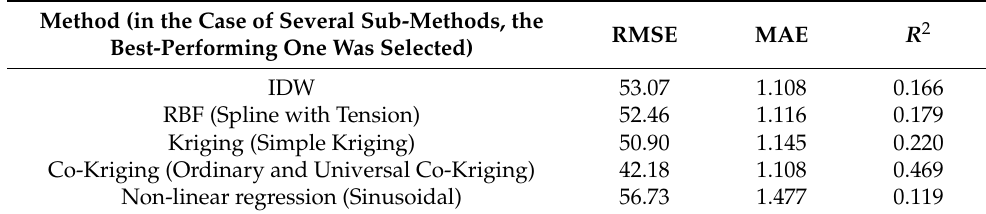
Table 7. Errors and correlations between observed and estimated annual precipitation amounts of the compared five